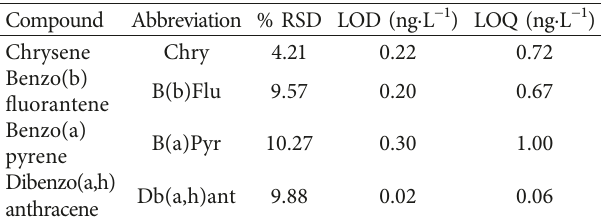
Figure 4: Optimising the amount of sorbent (in grams): chrysene (Chry), benzo(b)fluoranthene (B(b)Flu), benzo(a)pyrene (B(a)pyr), and dibenzo(a,h)anthracene Table 1: Results of the relative standard deviation (% RSD), limit of detection (LOD), and limit of quantification (LOQ).